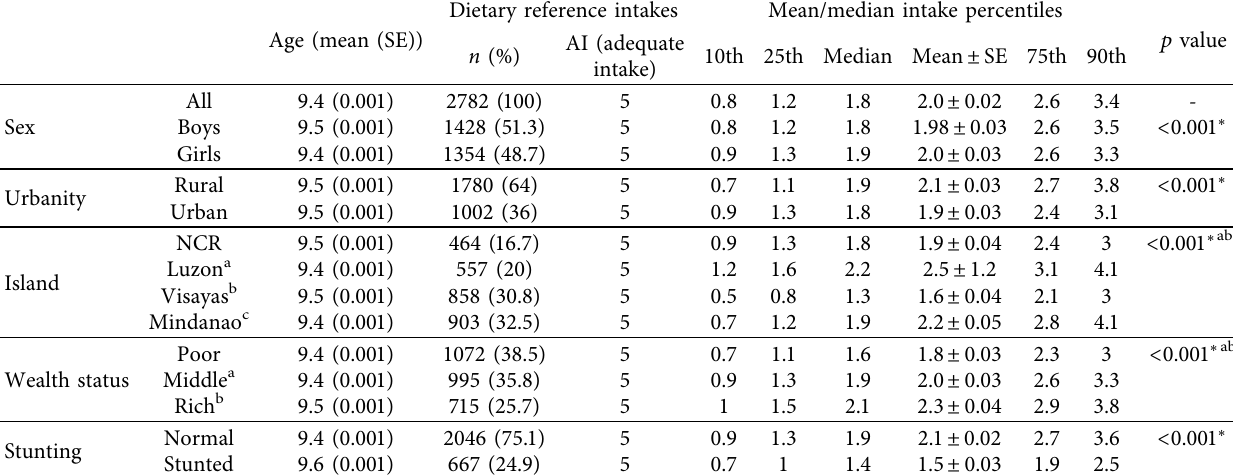
Table 2: Descriptive analysis and usual vitamin D intake of